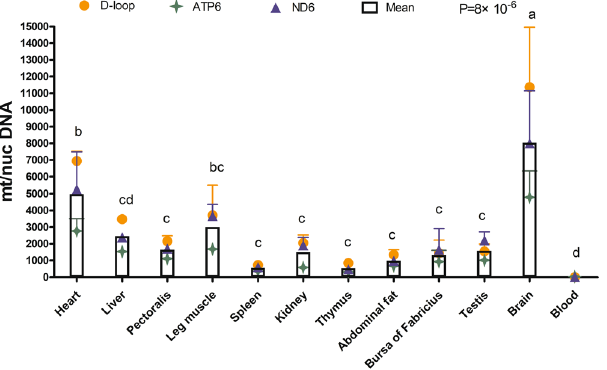
Figure 1. Variation in mtDNA copy number in various tissues of 21 d broilers. mt/nucDNA = mtDNA relative to nuclear DNA ( GCG ) copy number. Different letters indicate P < 0.05, and the same or no letter indicates P > 0.05. n =